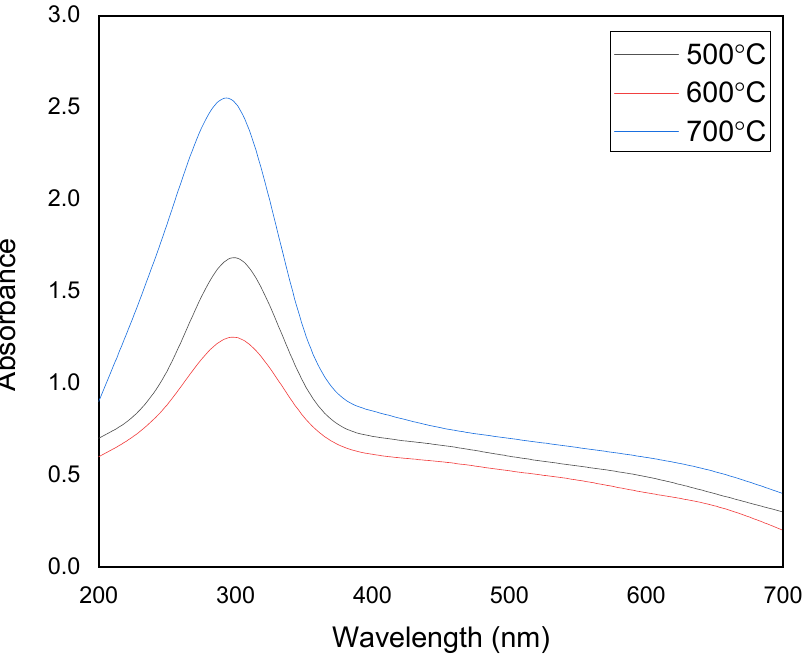
Figure 4. UV absorption profiles of MgFe 2 O 4 -NH 2 samples calcined at different temperatures.